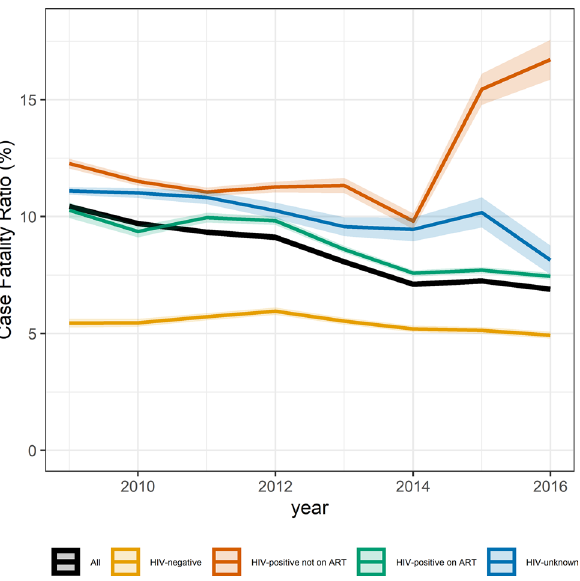
Figure 1. Overall South African case fatality ratio and 95%CI for adults (≥ 15 years) routinely treated for drug- susceptible tuberculosis, stratified by HIV status 2009–2016. ART: antiretroviral therapy; TB: tuberculosis. Case fatality ratio is calculated as percentage of deaths among all those with TB, regardless of known or unknown outcomes.